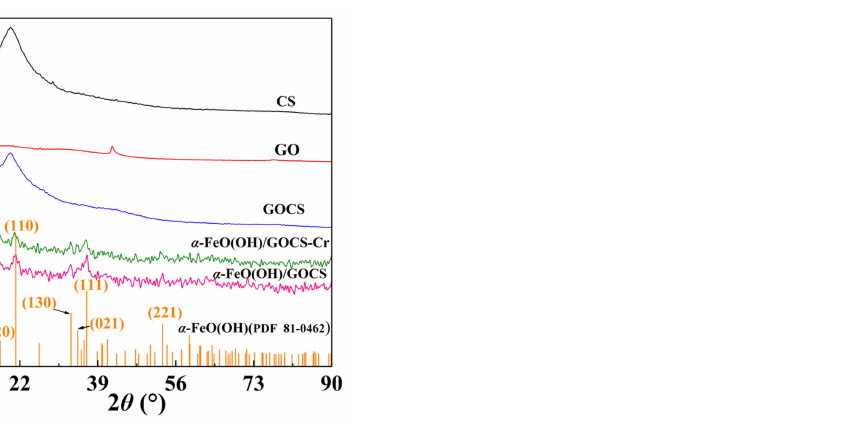
Figure 1. XRD patterns of GO, CS, GOCS, α –FeO(OH)/GOCS before Cr(VI) adsorption, and that of α –FeO(OH)/GOCS after adsorption for Cr(VI).